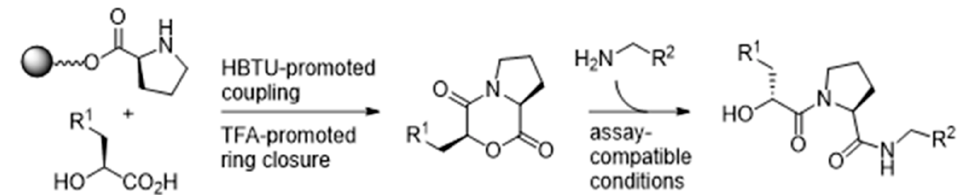
Figure 27. A Novel Approach to Traceless Generation of Serine Protease Inhibitors. 4.20. PROTAC Technology: A New Opportunity to Target Proteins Overexpressed in